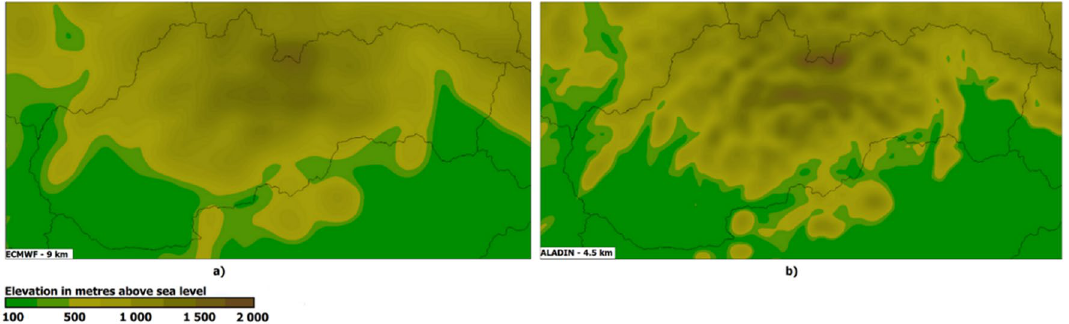
Figure 1. Comparison of NWP horizontal resolution model topography of Slovakia: ( a ) ECMWF; ( b )